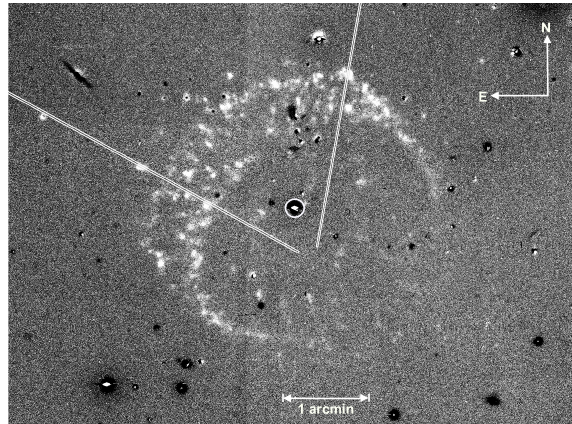
Figure 7: This H α + [NII] image of the classical nova shell around AT Cancri clearly shows the knots present. The knots are likely caused by Rayleigh-Taylor insta- bilities and are similar to those seen in GK Per (Shara et al. 2012a) and T Pyx (Shara et al. 1997, Schaefer et al. 2010, Toraskar et al. 2013) Figure reproduced with permission from Shara et al.